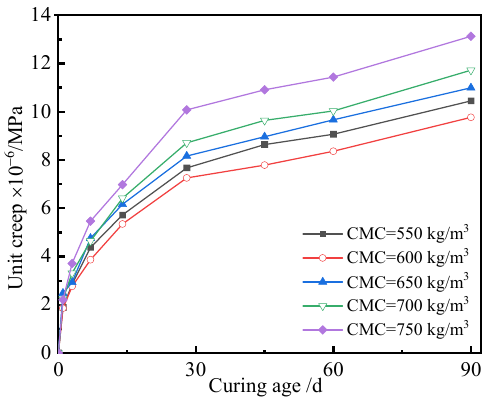
Figure 8. Unit creep curves of the UHPC with different contents of cementitious materials.